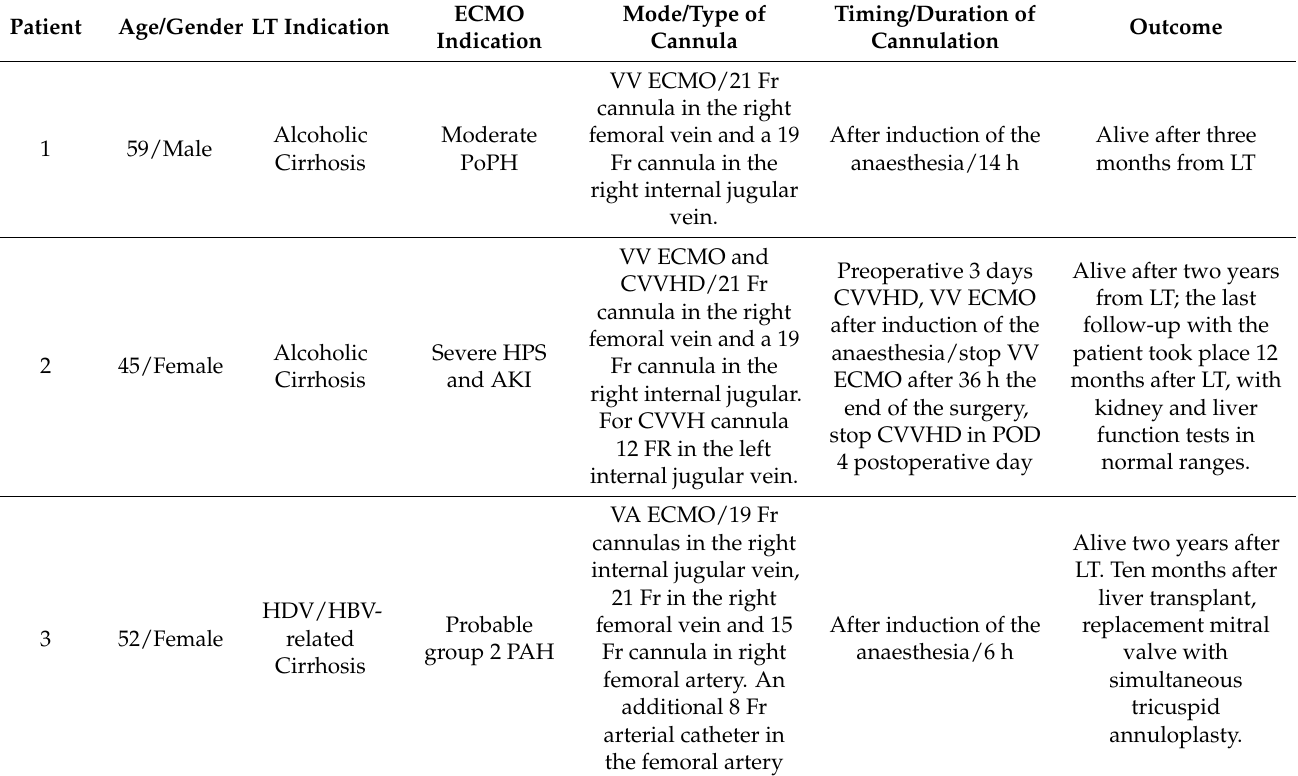
Table 3. Summary of clinical case